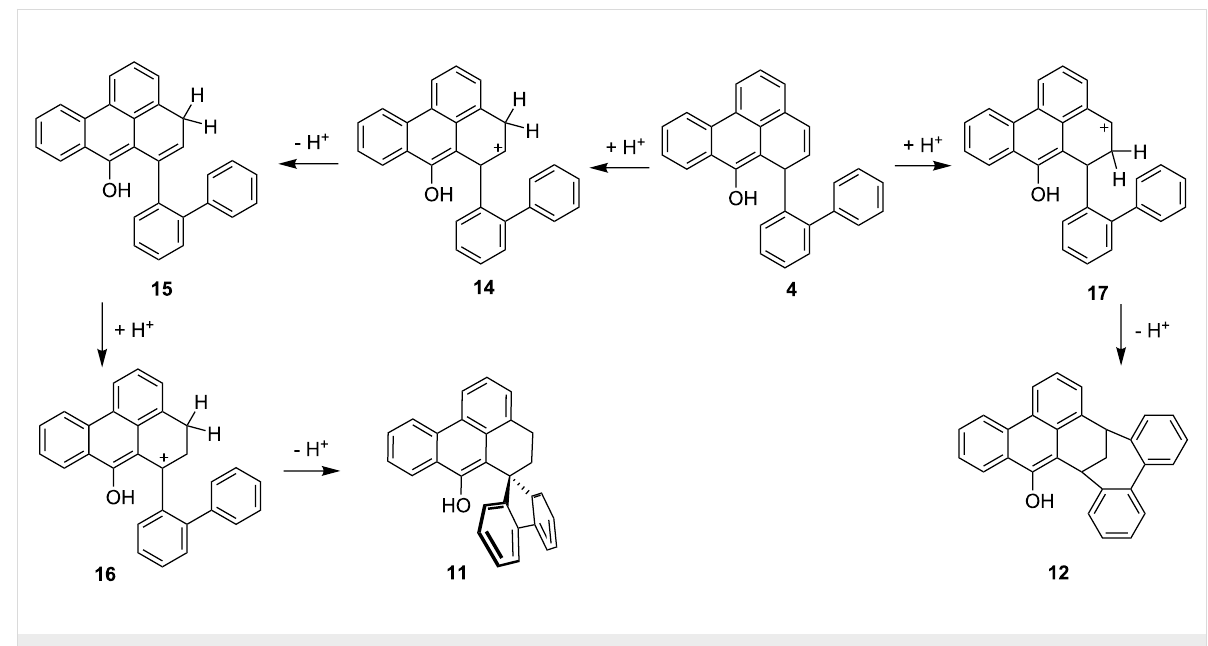
Compound 12 was characterised by NMR spectroscopy